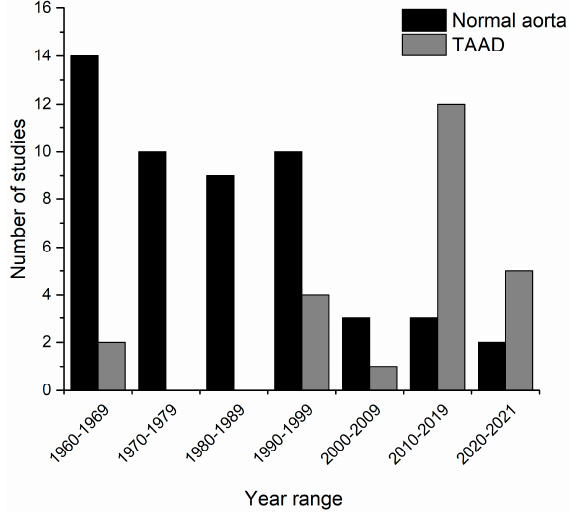
Figure 3. Number of studies in each category included in this review sub-divided by decade. Early studies largely focused on technique optimisation using normal aortic tissue, with TAAD studies following.